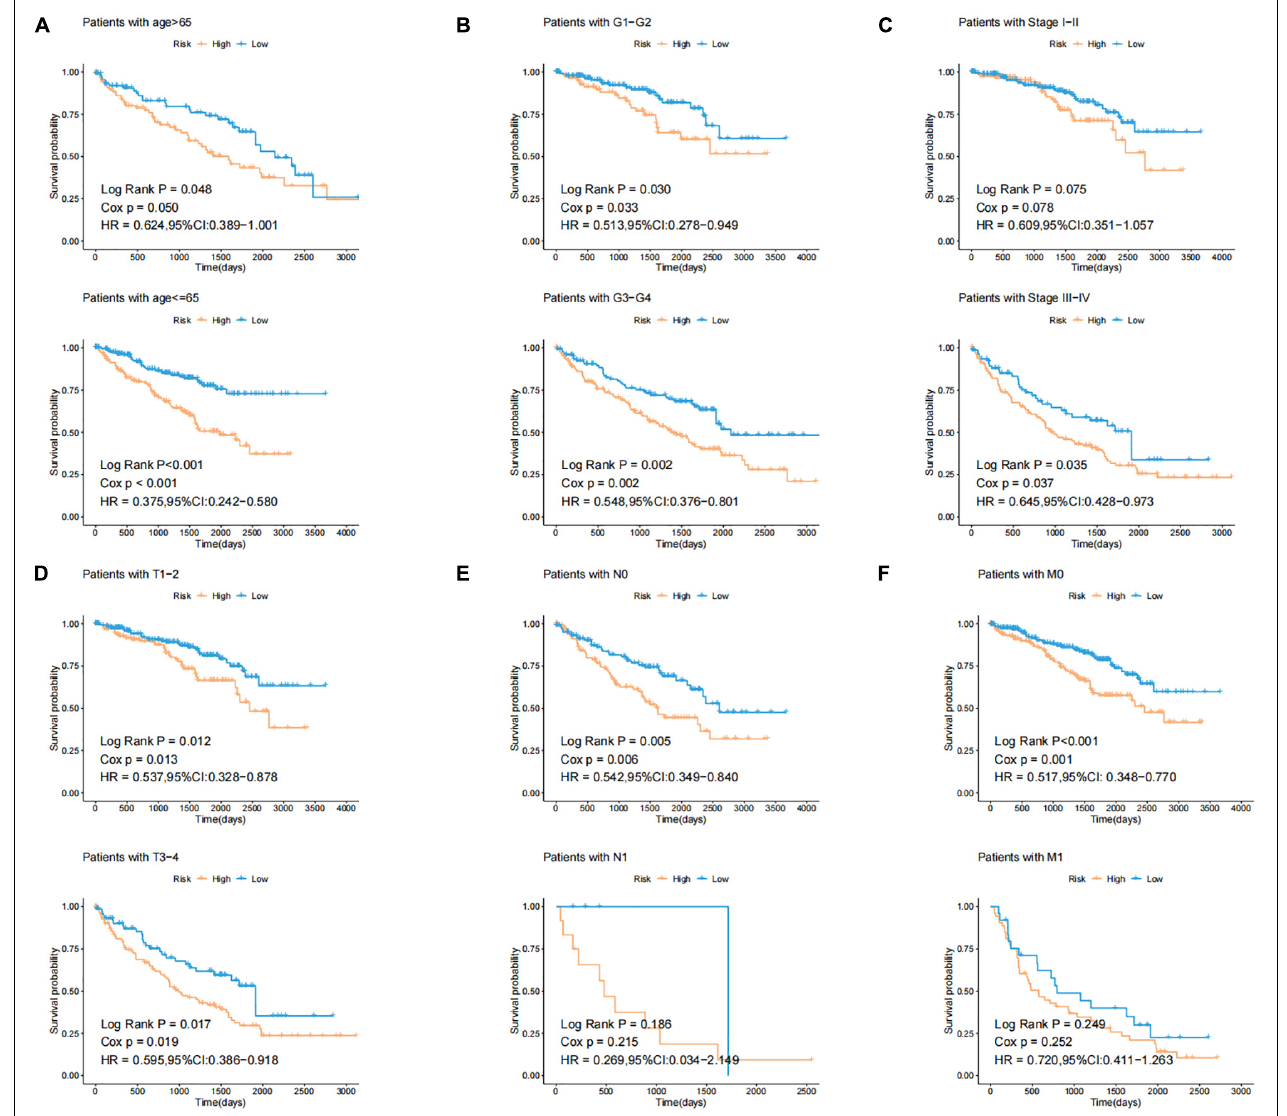
FIGURE 4 | Identification of the efficiency of GILncSig in specific clinical samples. (A) Kaplan–Meier curves of overall survival of patients with low or high risk predicted by the GILncSig in patients with Age < 65 and Age ≥ 65. (B) Kaplan–Meier curves of overall survival of patients with low or high risk predicted by the GILncSig in patients with G1-2 and G3-4. (C) Kaplan–Meier curves of overall survival of patients with low or high risk predicted by the GILncSig in patients with Stage I–II and Stage III–IV. (D) Kaplan–Meier curves of overall survival of patients with low or high risk predicted by the GILncSig in patients with T1-2 and T3-4. (E) Kaplan–Meier curves of overall survival of patients with low or high risk predicted by the GILncSig in patients with N0 and N1. (F) Kaplan–Meier curves of overall survival of patients with low or high risk predicted by the GILncSig in patients with M0 and